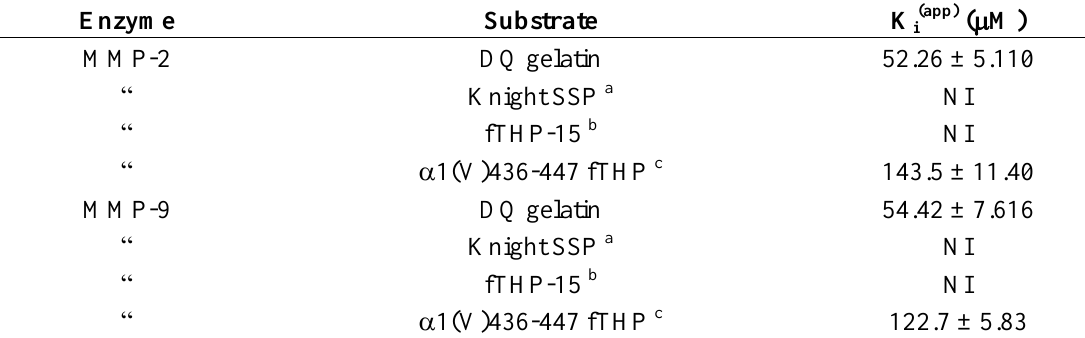
Table 2. Inhibition of MMPs by  1(I)715-721 THP [74]. NI = no